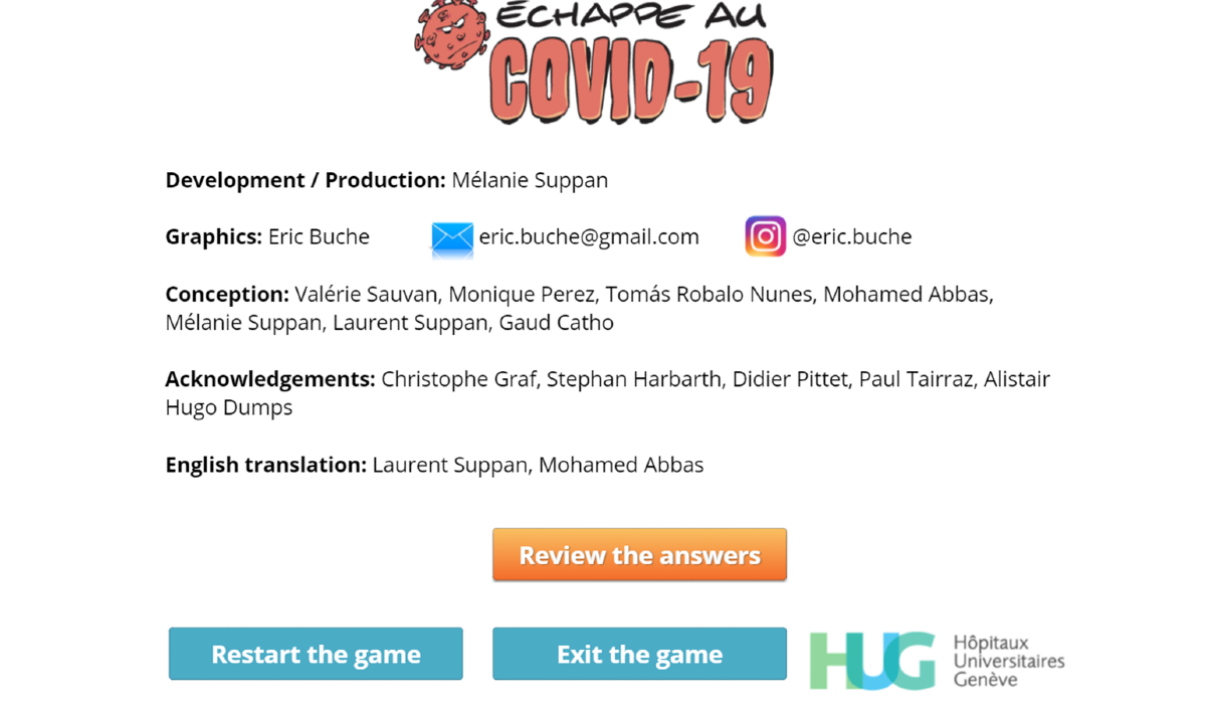
Figure 8. The only way participants could access the second questionnaire was by clicking on the “Exit the game”